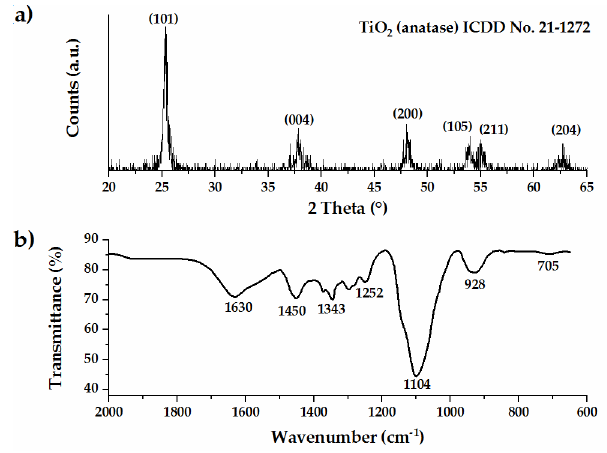
Figure 1. ( a ) X-ray diffraction (XRD) pattern; and ( b ) attenuated total reflectance–Fourier transform infrared (ATR-FTIR) spectrum of N–TiO 2 coating.